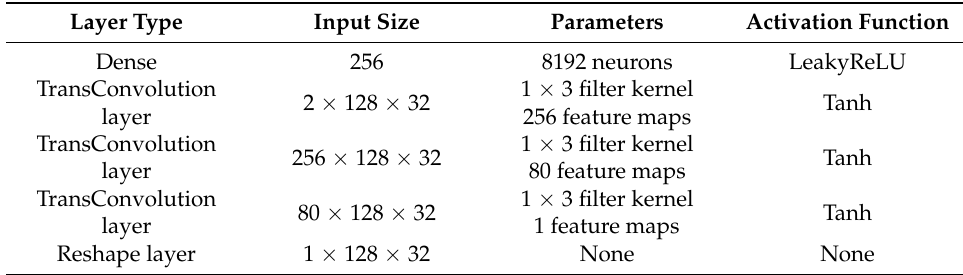
Table 3. Proposed generator